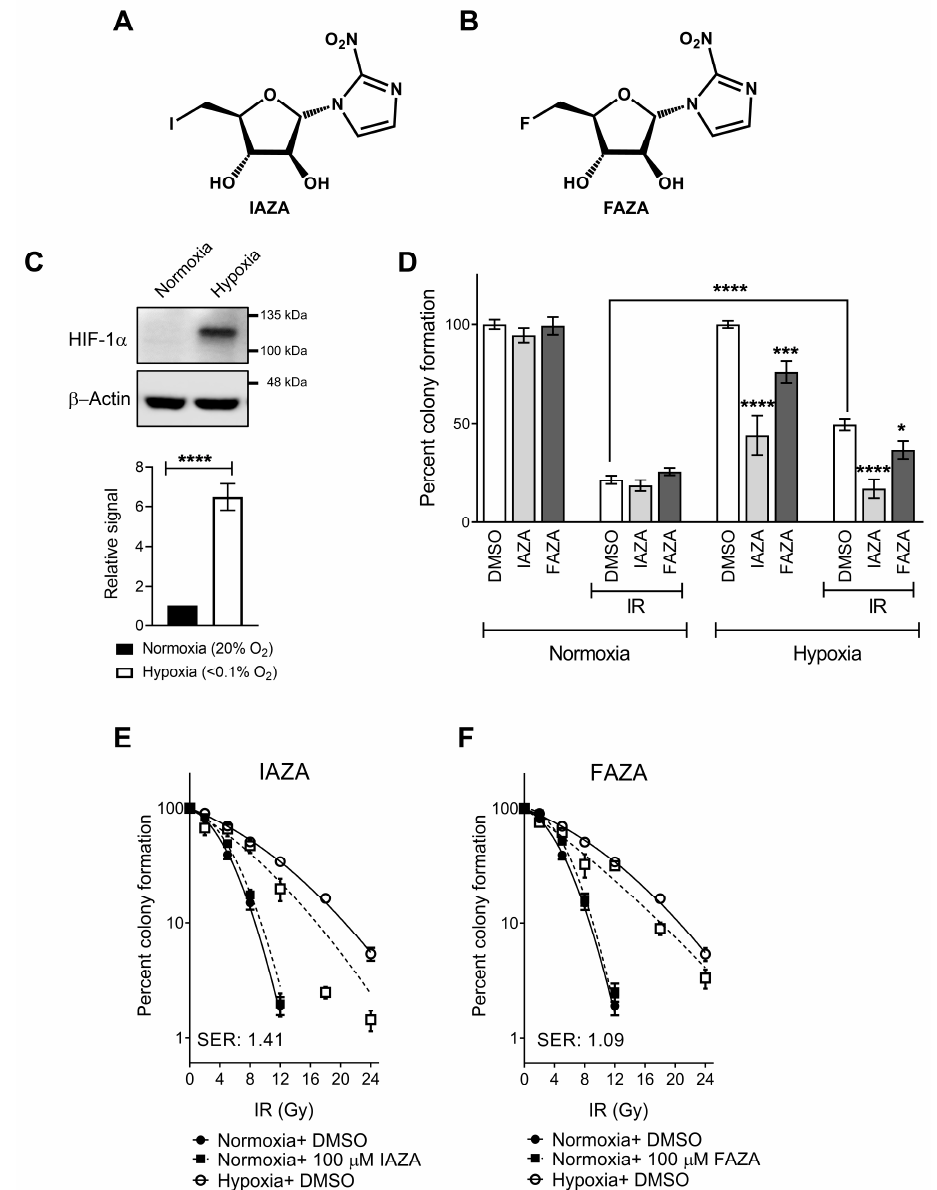
Figure 1. IAZA and FAZA sensitize hypoxic FaDu cells to IR. ( A , B ) Chemical structures for IAZA and FAZA. ( C ) Successful induction of hypoxia was confirmed by probing for HIF-1 α . ( D ) IAZA and FAZA significantly reduced clonogenicity in hypoxic irradiated cells. ( E , F ) Sensitization by IAZA and FAZA appear to be synergistic at higher radiation dosage. The calculated sensitizer enhancement ratios (SER) for IAZA and FAZA are indicated. Data show mean from at least three independent experiments; error bars represent standard error of the mean